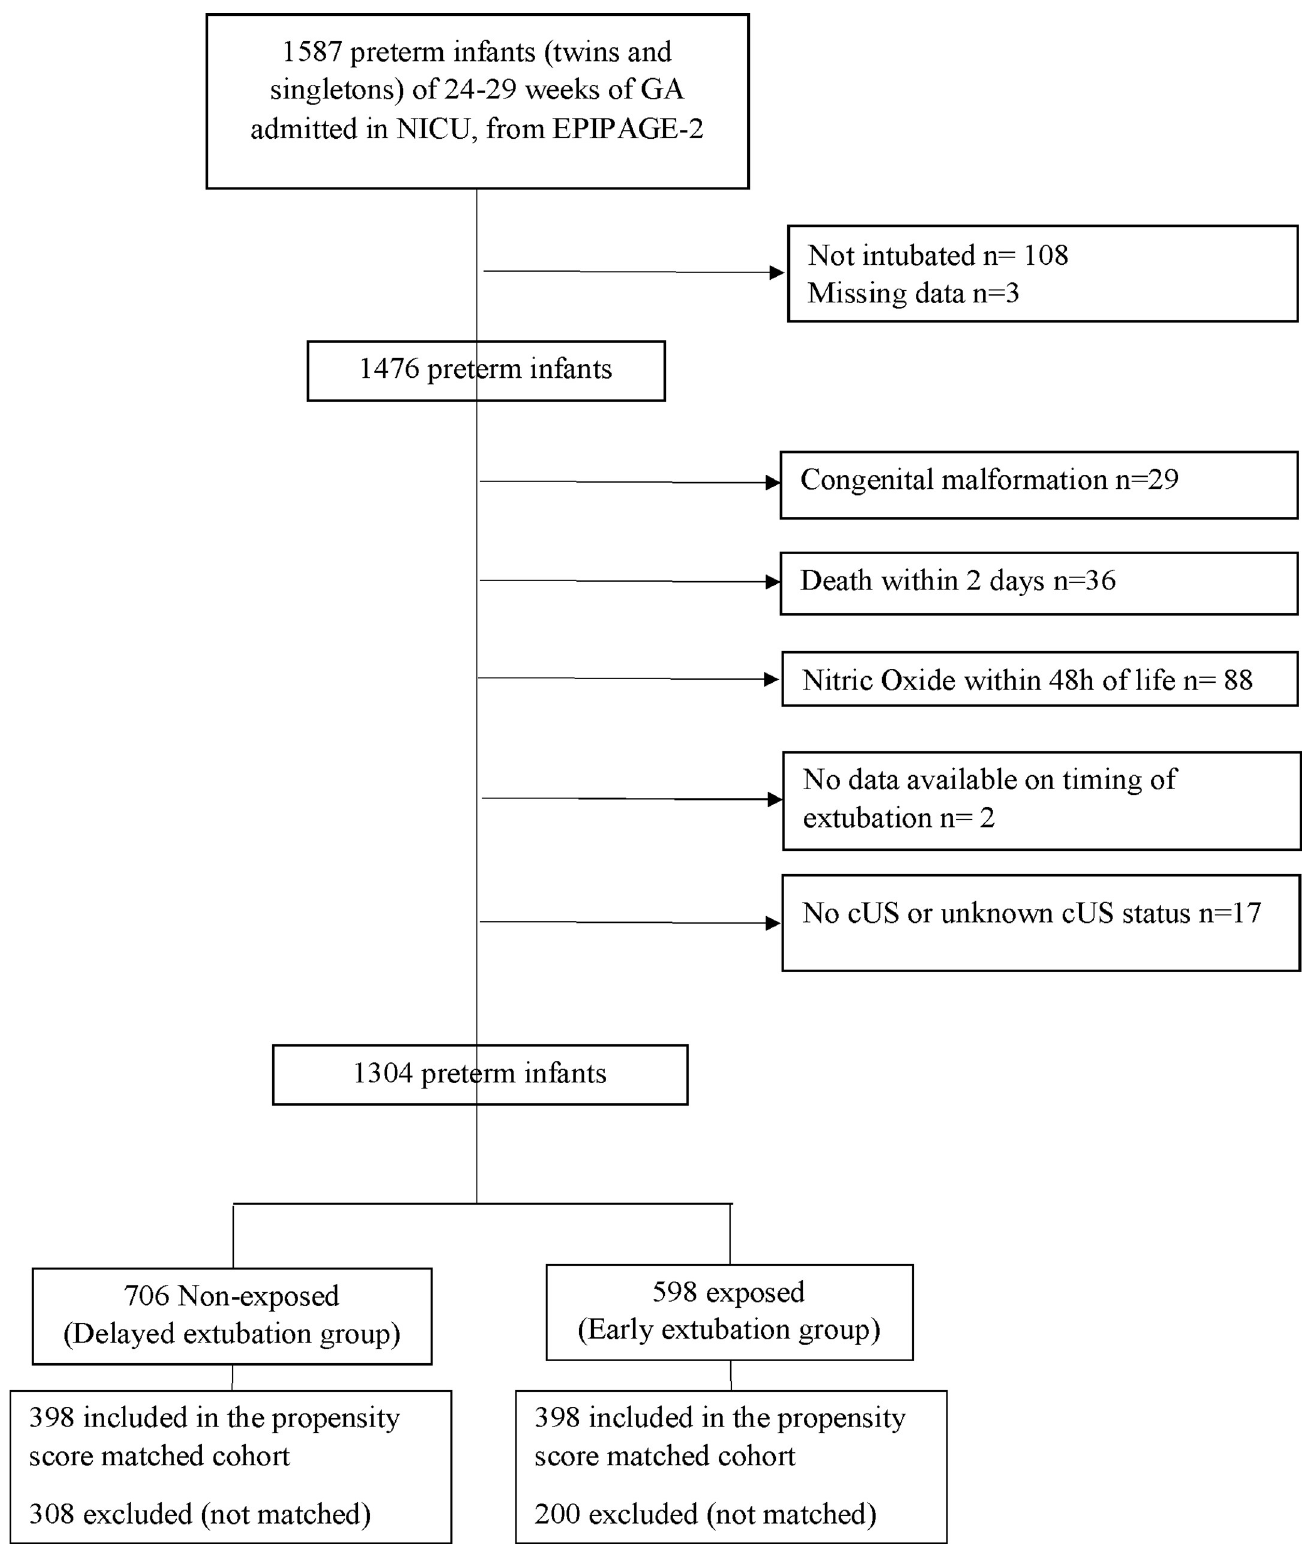
Fig 1. Study flow chart.